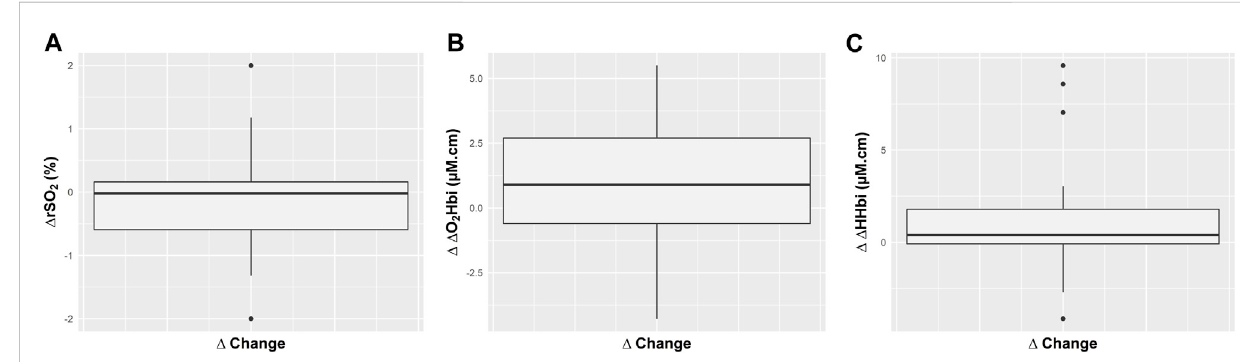
FIGURE 2 Boxplotsrepresentingtheeffectofincreasedpositiveend-expiratorypressure(PEEP)onabsolutechanges( Δ )inregionalcerebraloxygensaturation (rSO 2 ), and in the arterial ( Δ O 2 Hbi) and venous ( Δ HHbi) components of cerebral